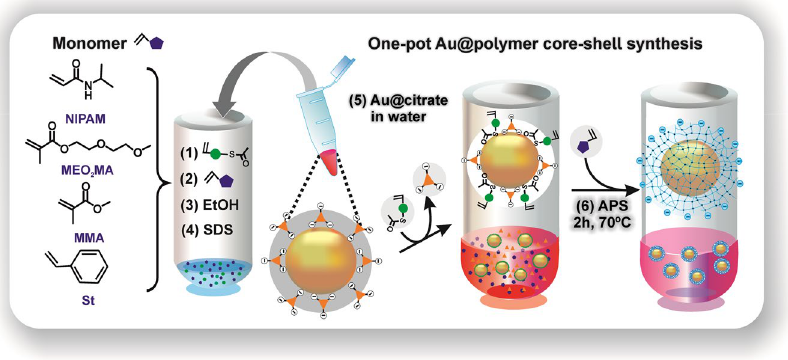
Figure 1. Cartoon describing: (right) Chemical route to ¨one-pot¨ synthesizing core-shell Au@polymer nanohybrids and (left) Structures of monomers used for polymer-shell coverage of